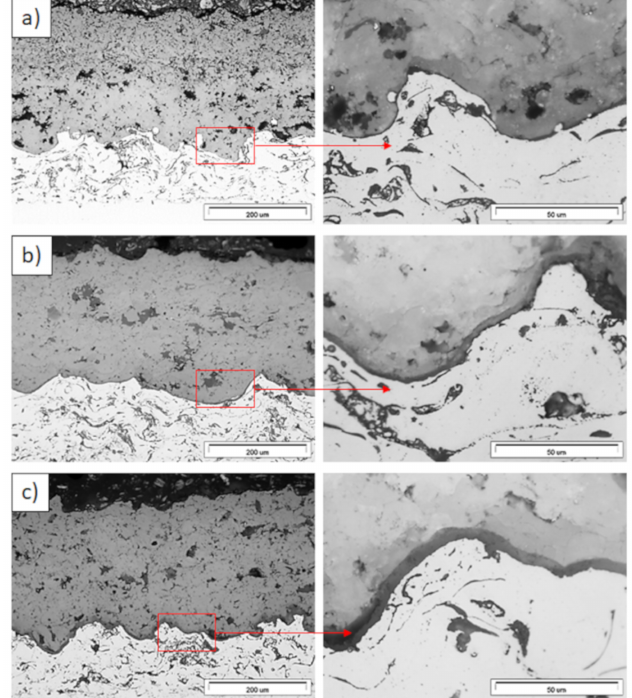
Figure 13. Ceramic layer / bond-coat interfaces of TBC systems as a function of oxidation time at a temperature of 1100 ◦ C—DCL La 2 Zr 2 O 7 / 50% La 2 Zr 2 O 7 + 50% 8YSZ / 8YSZ TBC (light microscopy): ( a ) 2 h, ( b ) 48 h, and ( c ) 175